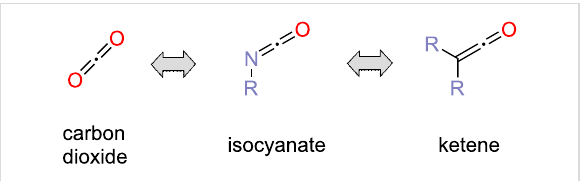
Figure 2: Examples of highly reactive molecules that are isoelectronic to carbon dioxide.